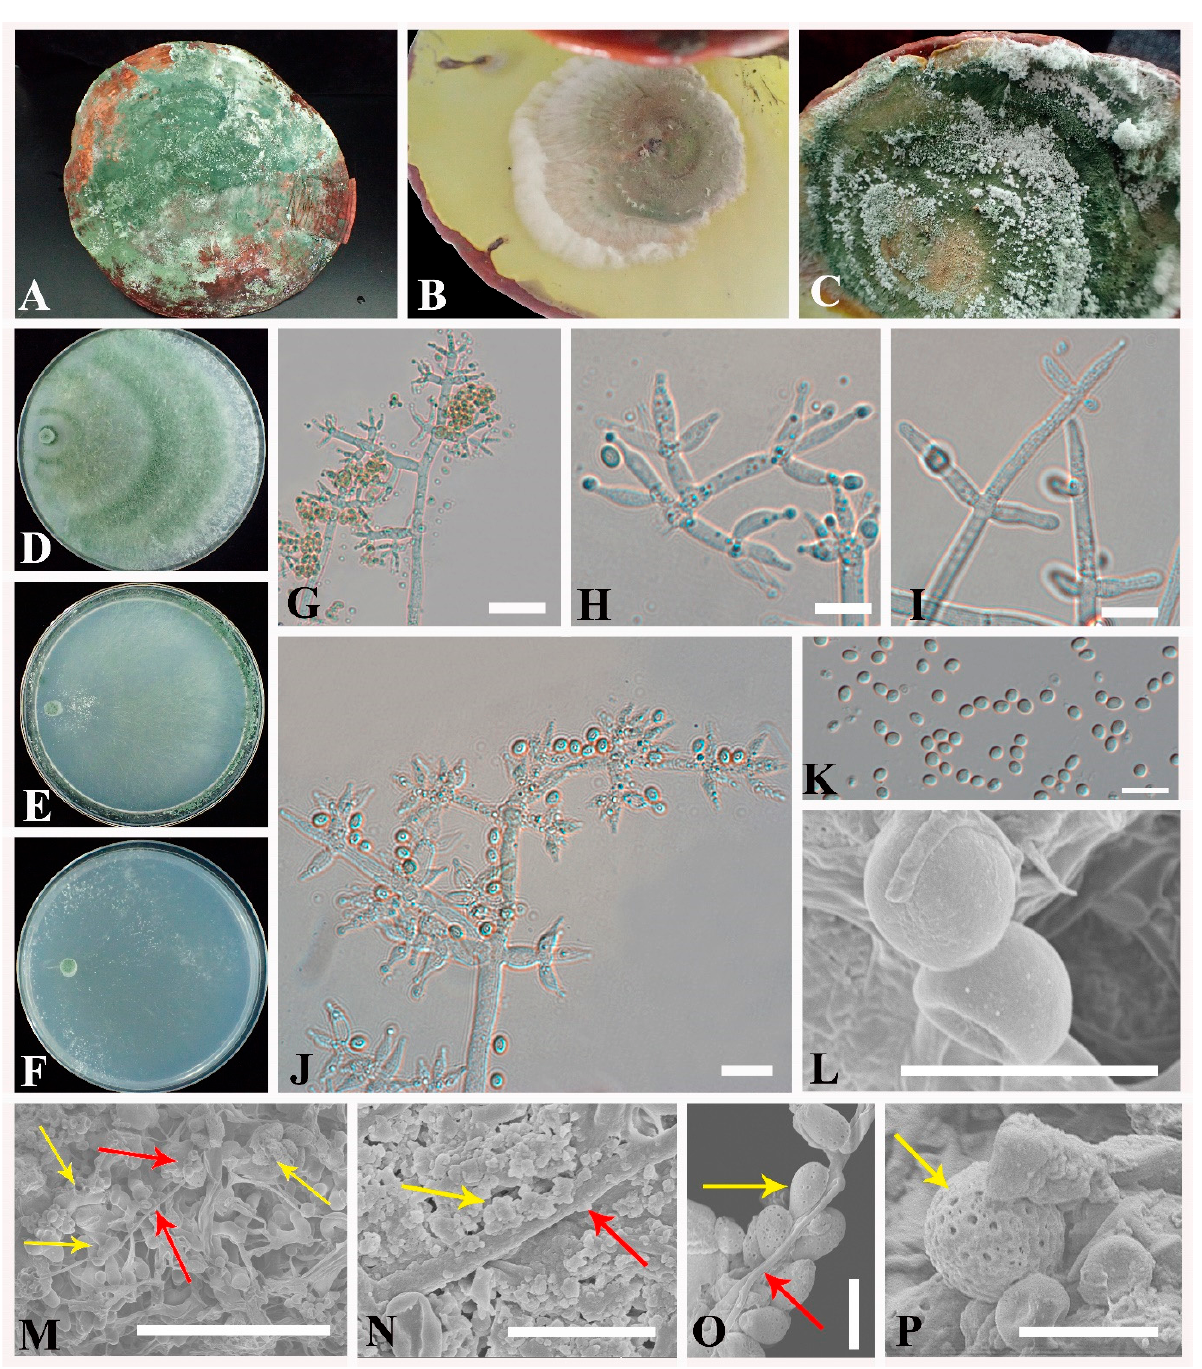
Figure 3. Morphological characteristics of T. ganodermatigerum . ( A – C ) diseased fruitbody; ( D – F ) colony on PDA, CMD, and SNA; ( G – J ) conidiophores and phialides; ( K , L ) conidia; ( M – P ) interactions of G. sichuanense and T. ganodermatigerum ; ( M ) Trichoderma hyphae and conidia are filled in the Ganoderma tissue, causing the tissue to become rough or even depressed; ( N ) Trichoderma hyphae covered with Ganoderma tissue; ( O ) clinged Trichoderma hyphae and healthy Ganoderma spores; ( P ) abnormal Ganoderma spores in diseased tissue. Bars: G, Q = 20 µ m; H–J, M–P = 10 µ m; K = 50 µ m; L = 5 µ m. The yellow arrows indicate the tissues and spores of G. sichuanense , and the red arrows indicate the hyphae and spores of T. ganodermatigerum